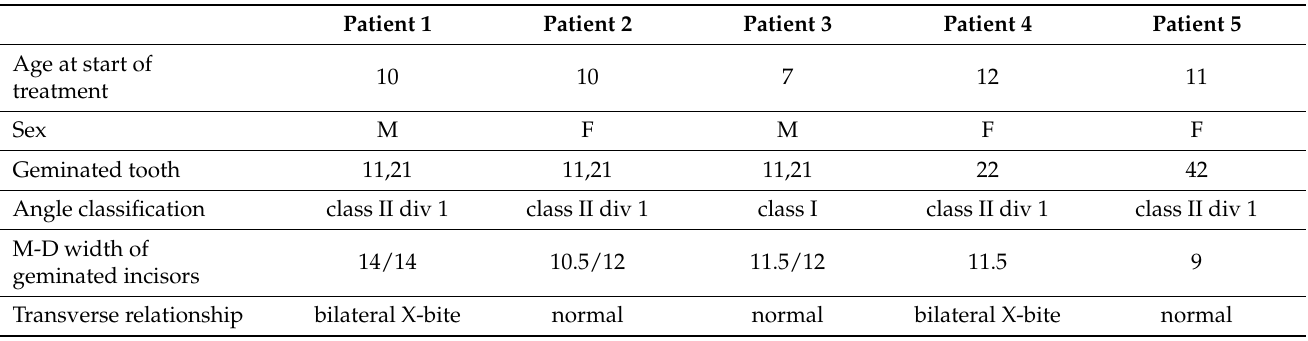
Table 2. Demographic data and clinical